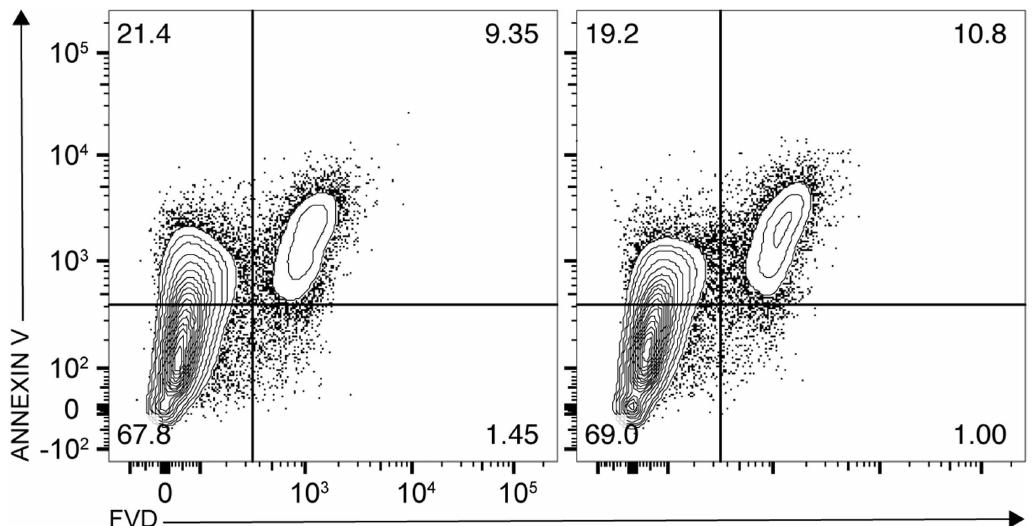
Figure 6. Percentage of living and apoptotic RAW 264.7 macrophages, untreated ( a ), or exposed for 24 h to 80 µ g Eq. of GA/mL ( b ). The percentage of living cells (67.8% and 69.0% respectively) early apoptotic cells (21.4% and 19.2%) and late apoptotic cells (9.35% and 10.8%) is not significantly different in untreated cells and cells treated with extract from onion